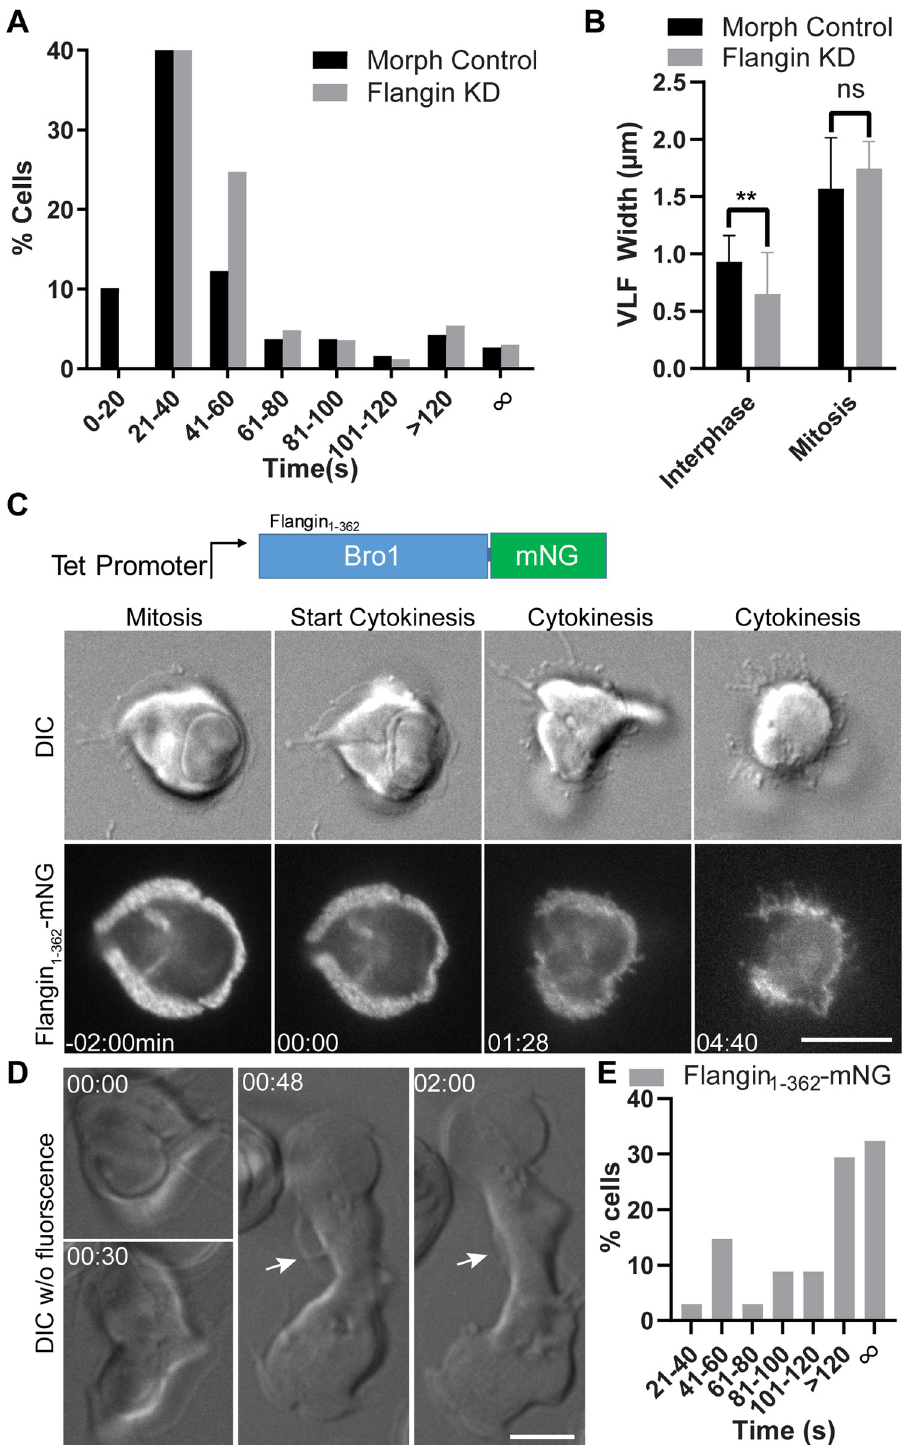
Fig 4. Flange breakdown is necessary for cleavage furrow progression. (A) Histogram showing the timing of cytokinesis for morpholino control (black) and Flangin KD cells (gray). See S4 and S5 Movies. Cytokinesis median time: control 31 sec (n = 188) and Flangin KD 35 sec (n = 166). Due to sampling frequency (timing between image stacks) the difference in median values in this experiment is not meaningful, similar to our previous study, more than 90% of the cells in both groups complete cytokinesis by 120 seconds indicating that there is no cytokinesis defect. (B)